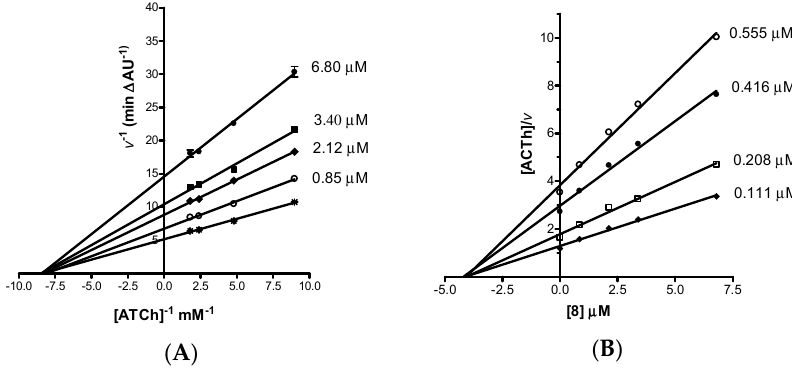
Figure 3. ( A ) Lineweaver-Burk plot and ( B ) Cornish-Bowden plot both illustrating non-competitive inhibition of Ee AChE by compound 8 . The intersection point in Cornish-Bowden plot gives an estimate of the inhibition constant. Lines were derived from a weighted least-squares analysis of data. ATCh = acetylthiocholine (substrate).